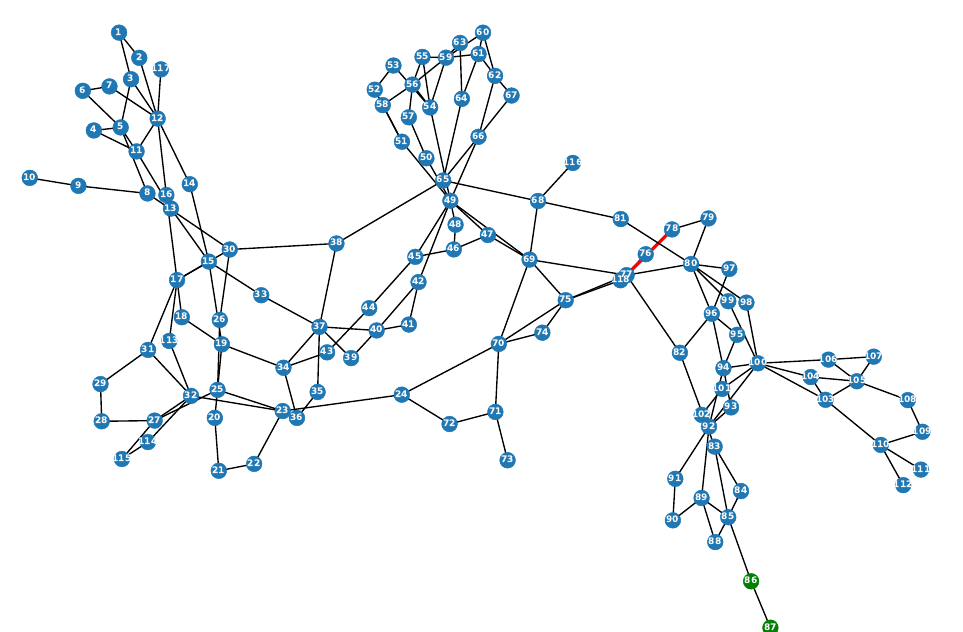
Figure 12. The optimal 2 × 75 MW demand and mobile MSSSC allocation during Season 2. Red lines indicate the mobile MSSSC deployment locations; green node indicates the load connection location.